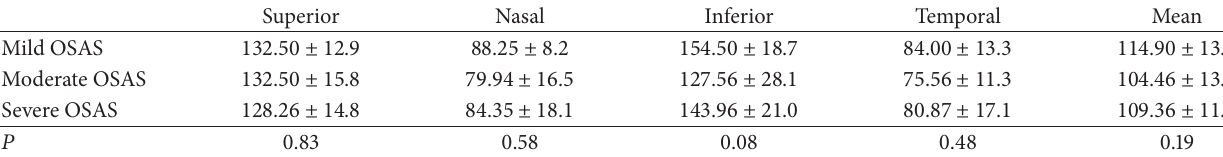
Table 3: RNFL thickness ( 𝜇 ) based on stages of OSAS.